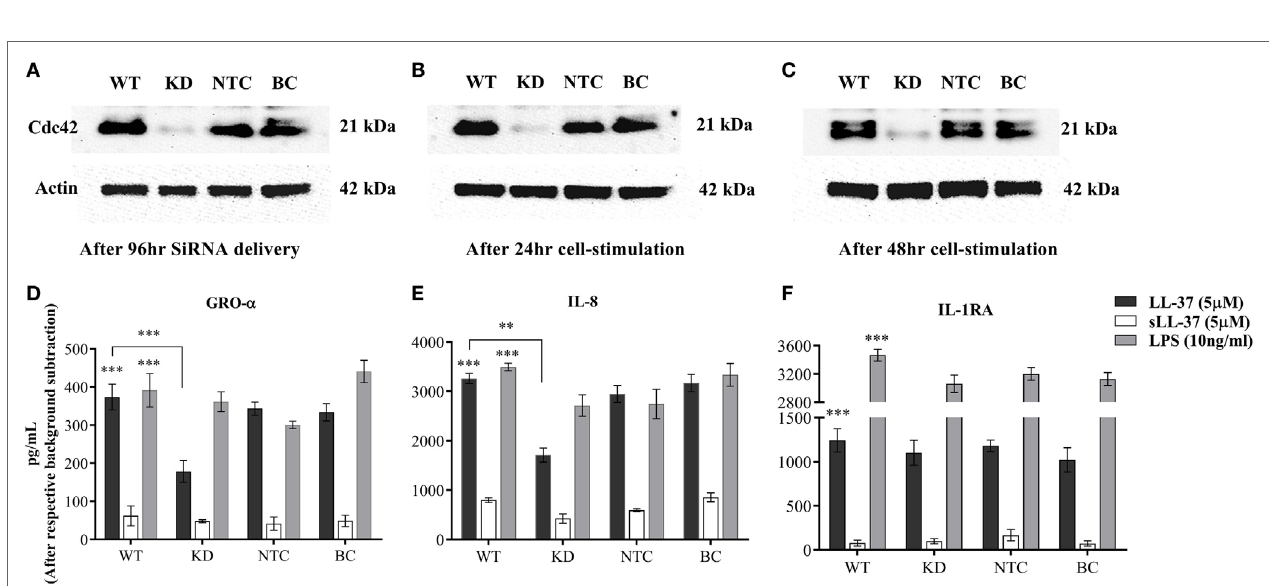
FigUre 8 | Knockdown of Cdc42 Rho GTPase suppresses LL-37-induced chemokine production, but not anti-inflammatory cytokine IL-1RA. Human monocytic THP-1 cells were treated with either human Cdc42 Accell SiRNA smartpool (1 µM) or non-target control (NTC) Accell SiRNA smartpool (1 µM) for 96 h. The efficiency of knockdown was determined by western blots probing with Cdc42 antibody and protein loading using actin antibody, after (a) 96 h of SiRNA delivery, and subsequently following cell differentiation to plastic-adherent, macrophage-like THP-1 cells after additional (B) 24 and (c) 48 h. Macrophage-like THP-1 cells, either wild type, knockdown (KD), or cells treated with 50 µl SiRNA buffer (BC), were stimulated with LL-37 (5 µM), sLL-37 (5 µM each) or lipopolysaccharide (10 ng/ ml). Tissue culture supernatants were monitored by ELISA for the production of chemokines (D) GRO- α and (e) IL-8 after 24 h, and for (F) anti-inflammatory cytokine IL-1RA after 48 h. Results shown as mean ± SE of three independent experiments ( n = 3). Analysis of variance with Bonferroni’s post hoc test was used for statistical analyses (** p < 0.005, *** p < 0.0005).